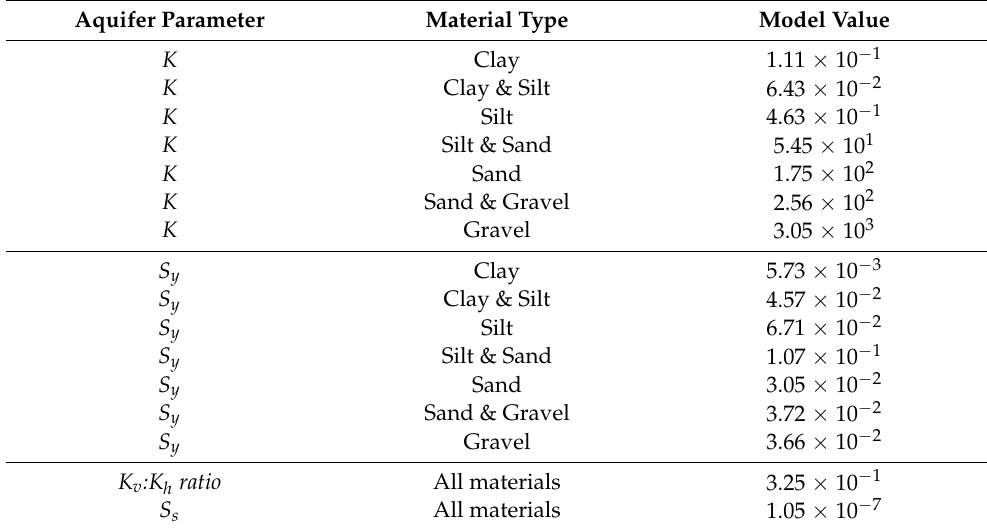
Table 1. Aquifer properties and corresponding values used in the MODFLOW model, as determined through model calibration [10]. K values are in m/day.